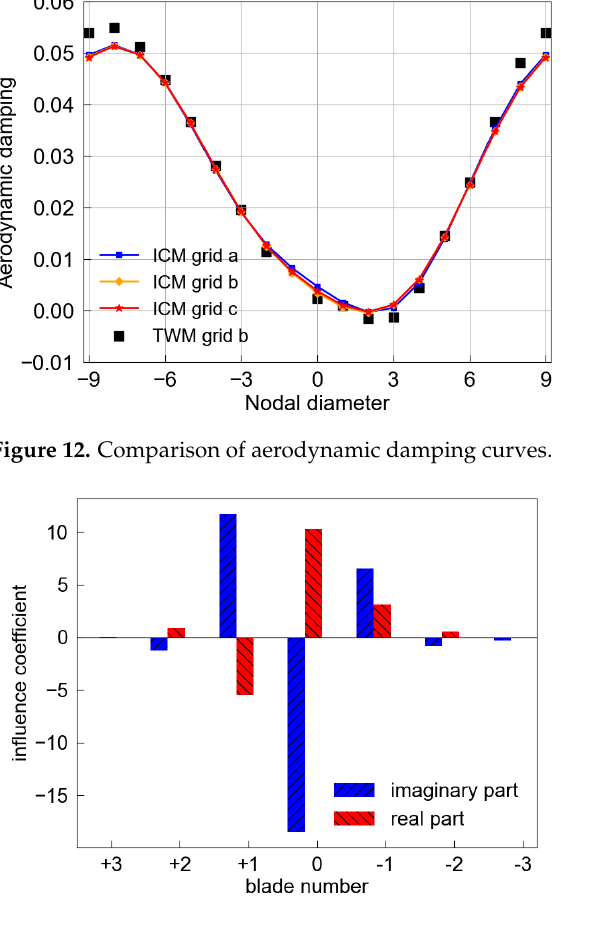
Figure 13. The real and imaginary parts of influence coefficients based on grid